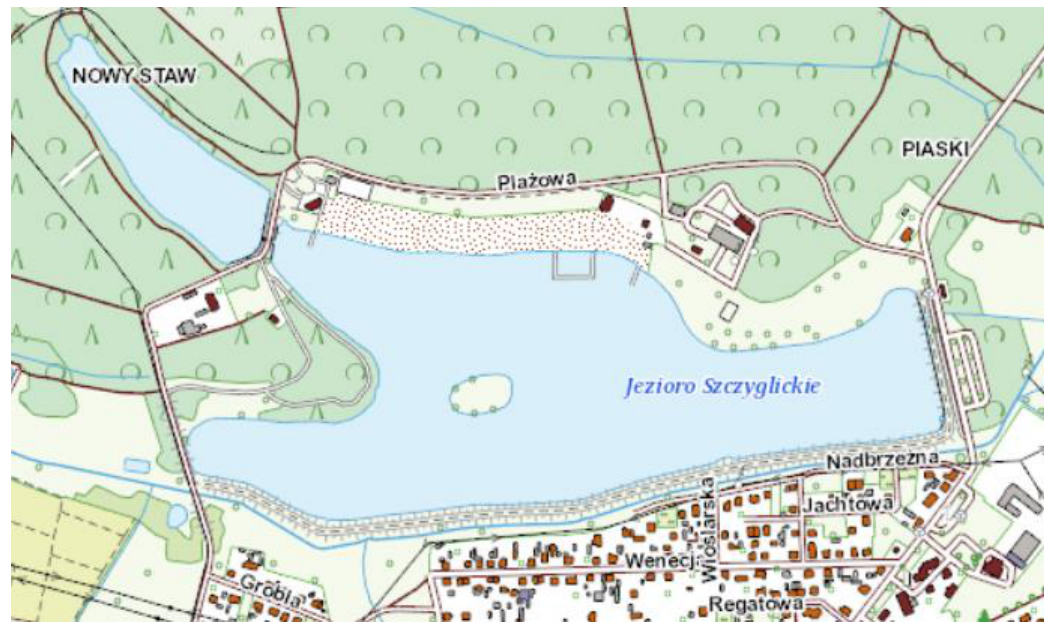
Figure 1. View of the research place.